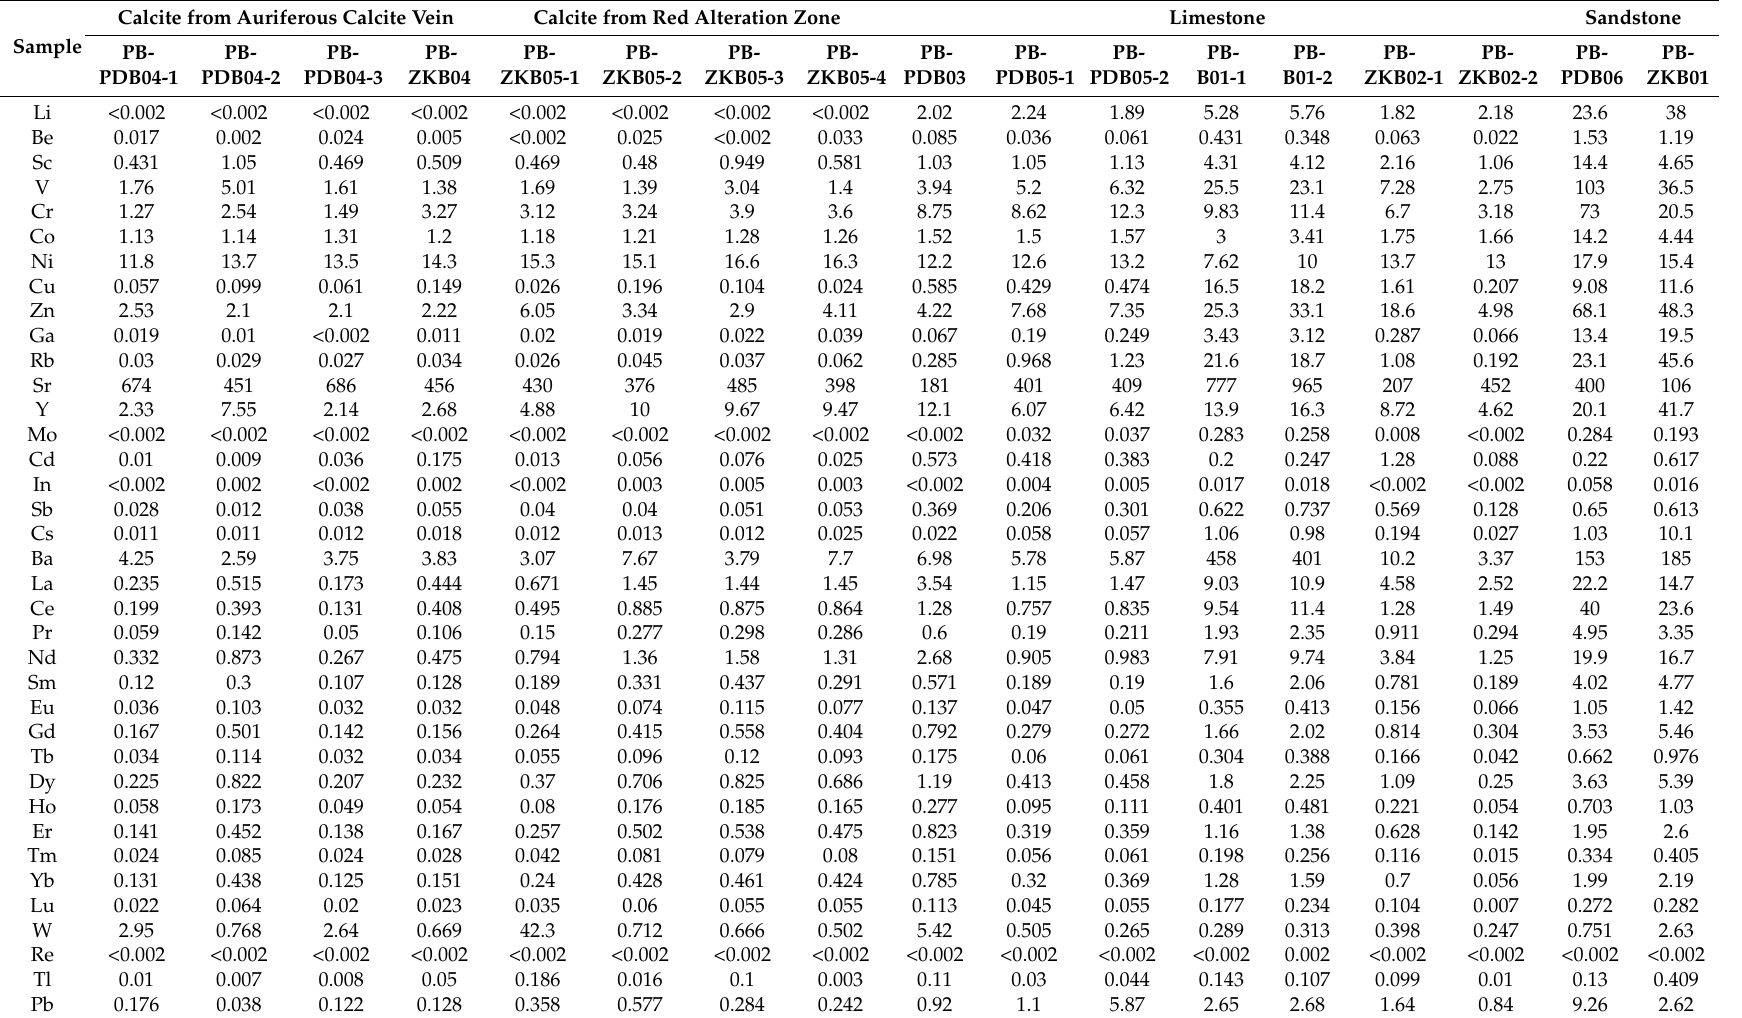
Table 2. Trace element and REE concentrations ( × 10 − 6 ) in calcite, limestone and sandstone from the Phapon